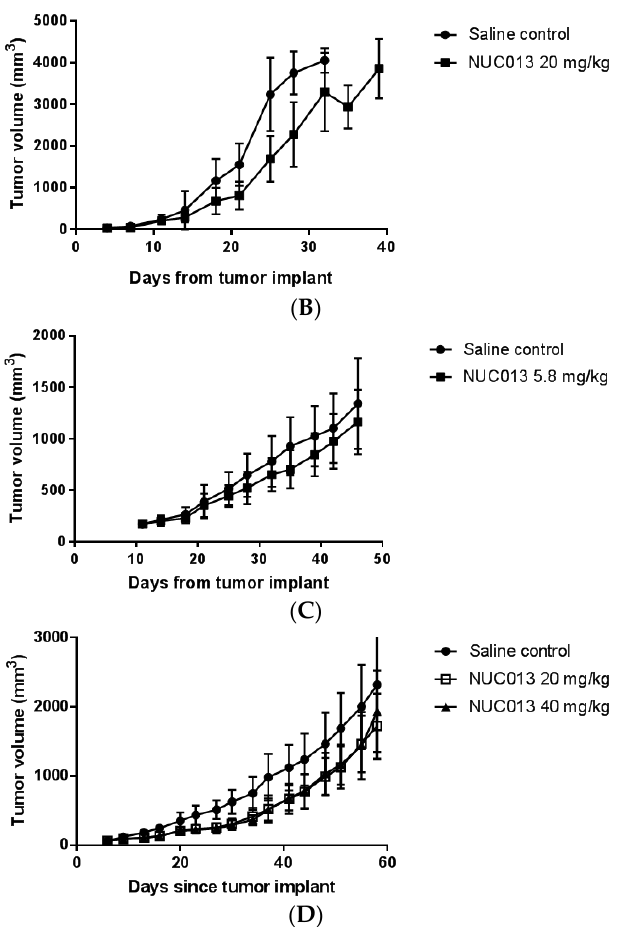
Figure 4. Tumor volume as a function of time since tumor implant. The first data point on each graph is on the day of study drug treatment initiation. Values are ± standard deviation. ( A ) HL-60 comparison of NUC013 5.8 mg/kg vs. saline control; ( B ) HL-60 comparison of NUC013 20 mg/kg vs. saline control; ( C ) LoVo comparison of NUC013 5.8 mg/kg vs. saline control; ( D ) LoVo comparison of NUC013 20 mg/kg and 40 mg/kg vs. saline control.